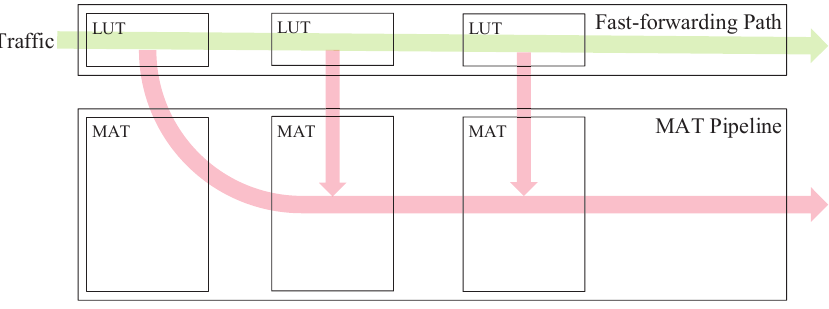
Figure 4. The architecture of the composite pipeline with an